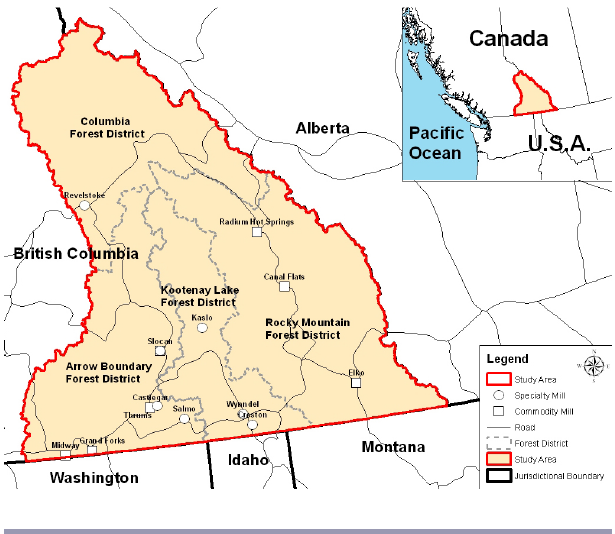
Fig. 1 . The Columbia-Kootenay portion of the Southern Interior Forest Region. Formerly this area was the Kootenay Forest